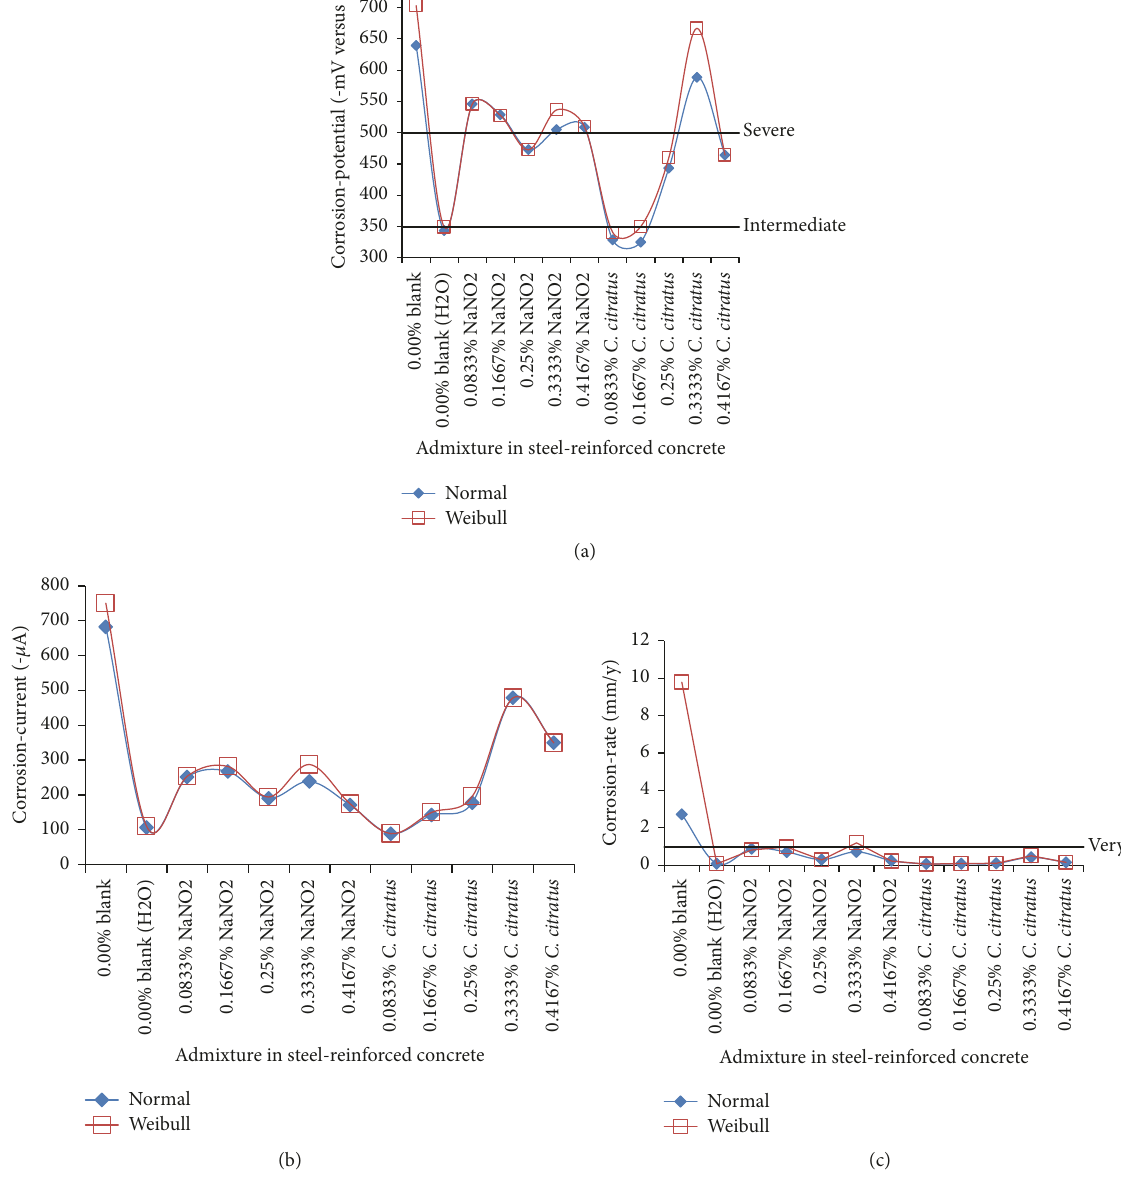
Figure 1: Results of statistical analyses of the Normal and Weibull distribution models detailing mean/average corrosion test-responses from electrochemical monitored steel-reinforced concrete samples: (a) corrosion-potential, (b) corrosion-current, and (c)